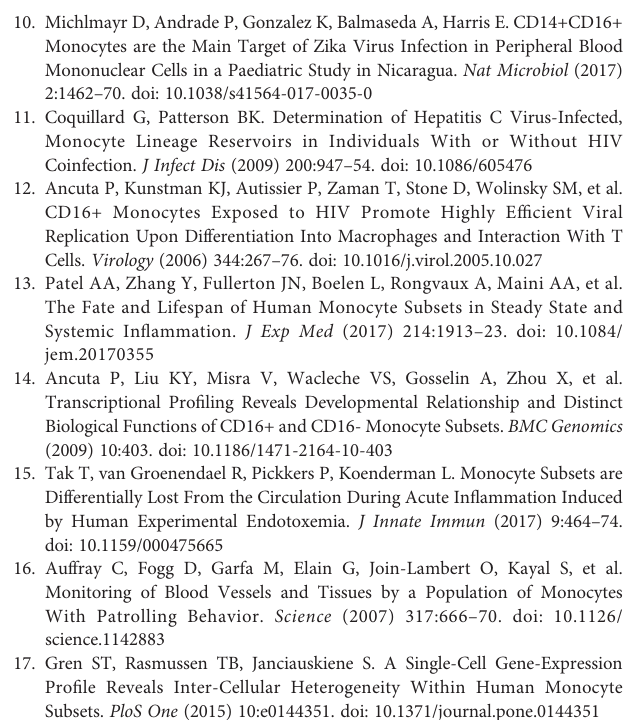
Supplementary Figure 1 | Parental gating strategy used in all fl ow cytometric analyses. Debris was minimized using light scatter gating followed by single cell analysis to eliminate doublets. CD45 positive selection and CD19 (B-cell)/CD3 (T- cell) negative selection was also utilized to optimize monocyte selection for analysis and